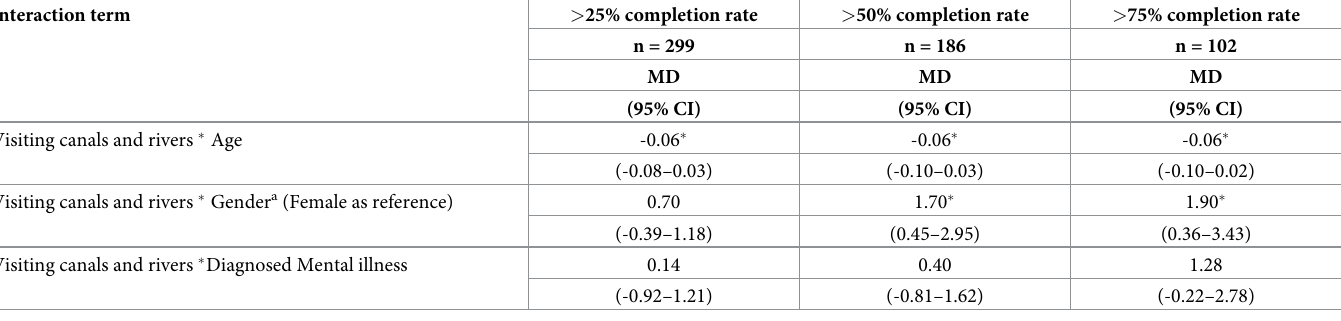
Table 3. Interaction effects of age, gender, ethnicity, and having a diagnosed mental illness on the association between visiting canals/rivers versus being anywhere else and mental wellbeing. Interaction